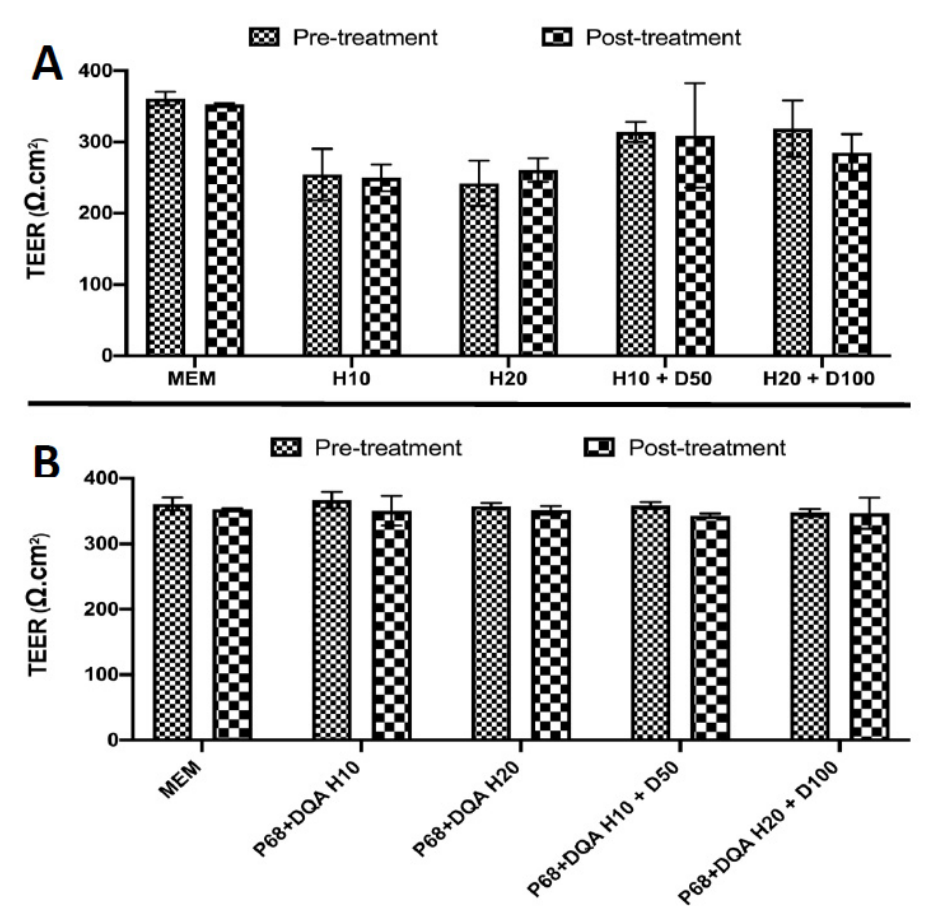
Figure 5. ( A ) Mean TEER of hCMEC/D3 cell monolayers on day 5 post seeding before (pre-treatment) and after (post-treatment) treatment with HT and combined HT and DFO free drug treatments. ( B ) Corresponding TEER results for the P68 + DQA nanoformulated HT and HT + DFO treatments.